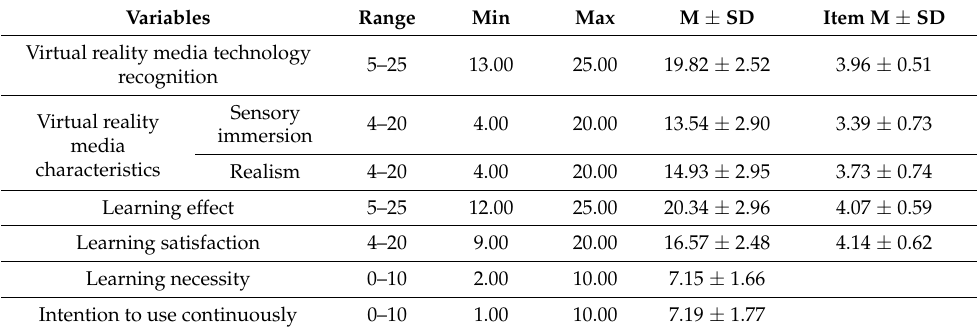
Table 2. Level of virtual reality media technology recognition, media characteristics, learning effect, satisfaction, learning necessity, and continuous use